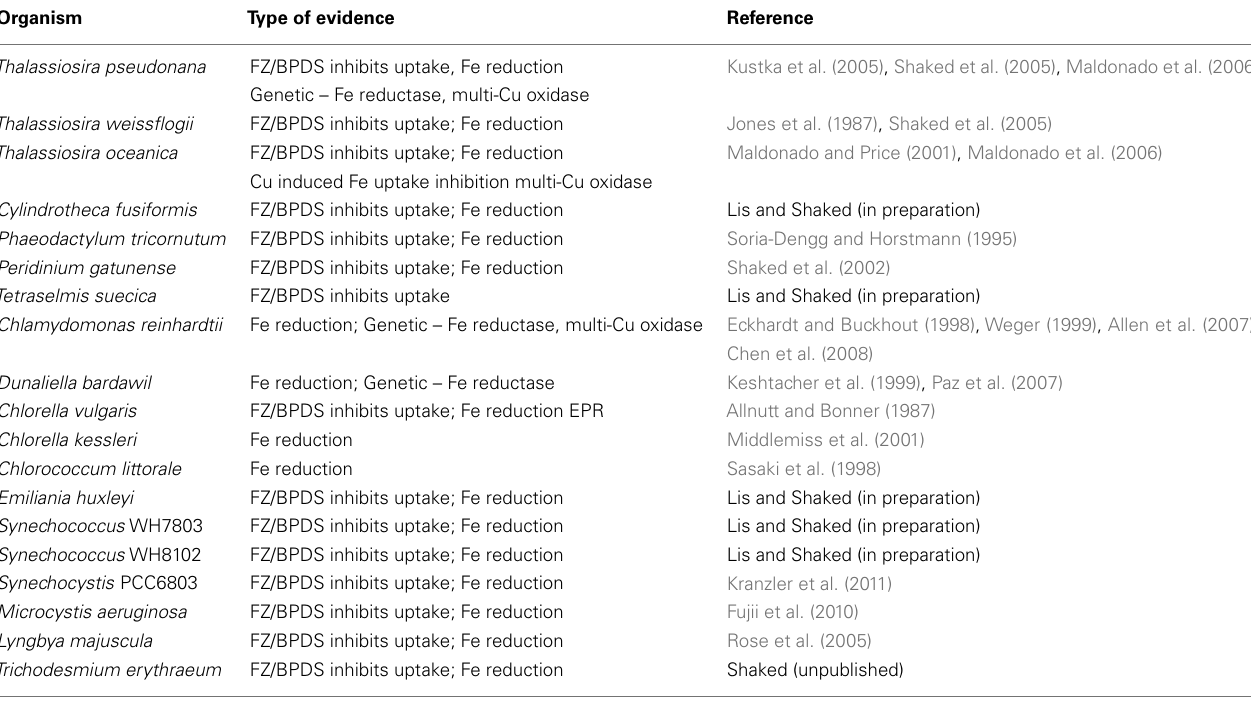
TableA1 | Experimental evidence showing the existence of an iron reductive uptake pathway in laboratory cultures.